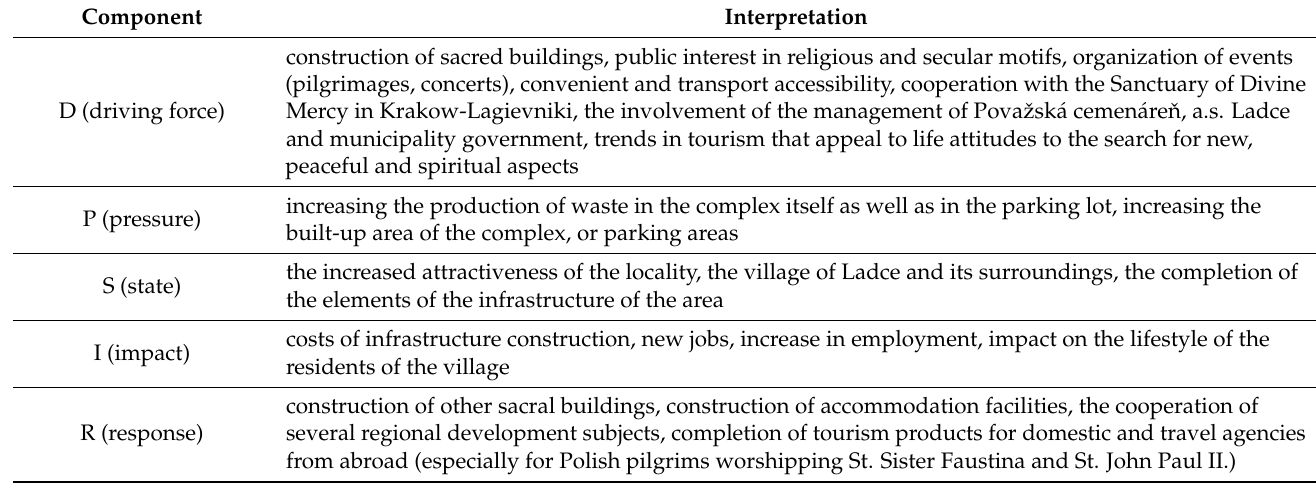
Table 2. DPSIR model for